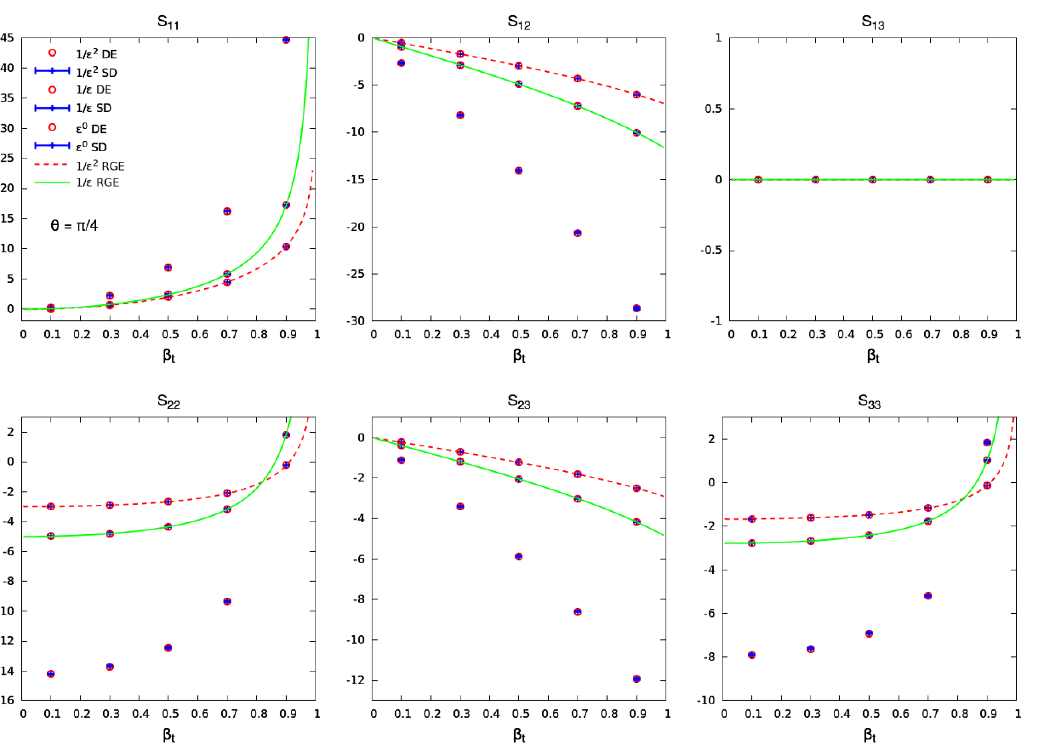
Figure 15 . Quark bubble contribution to the NNLO soft function in the gg channel. The plots correspond to six independent entries of the 3 (cid:2) 3 matrix determined for the (cid:12)xed values of (cid:18) = (cid:25)= 4 and L ? = 0. We see perfect agreement between RG prediction and the direct calculation